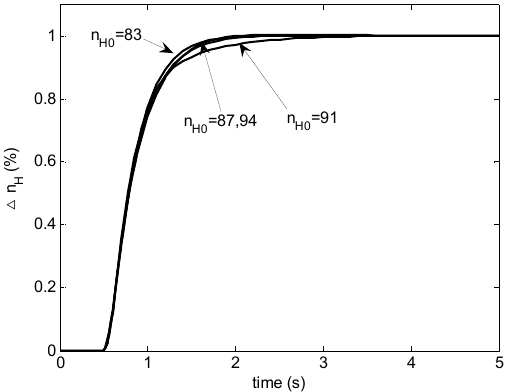
Figure 14. Step responses with the modified H ∞ LPV controller.